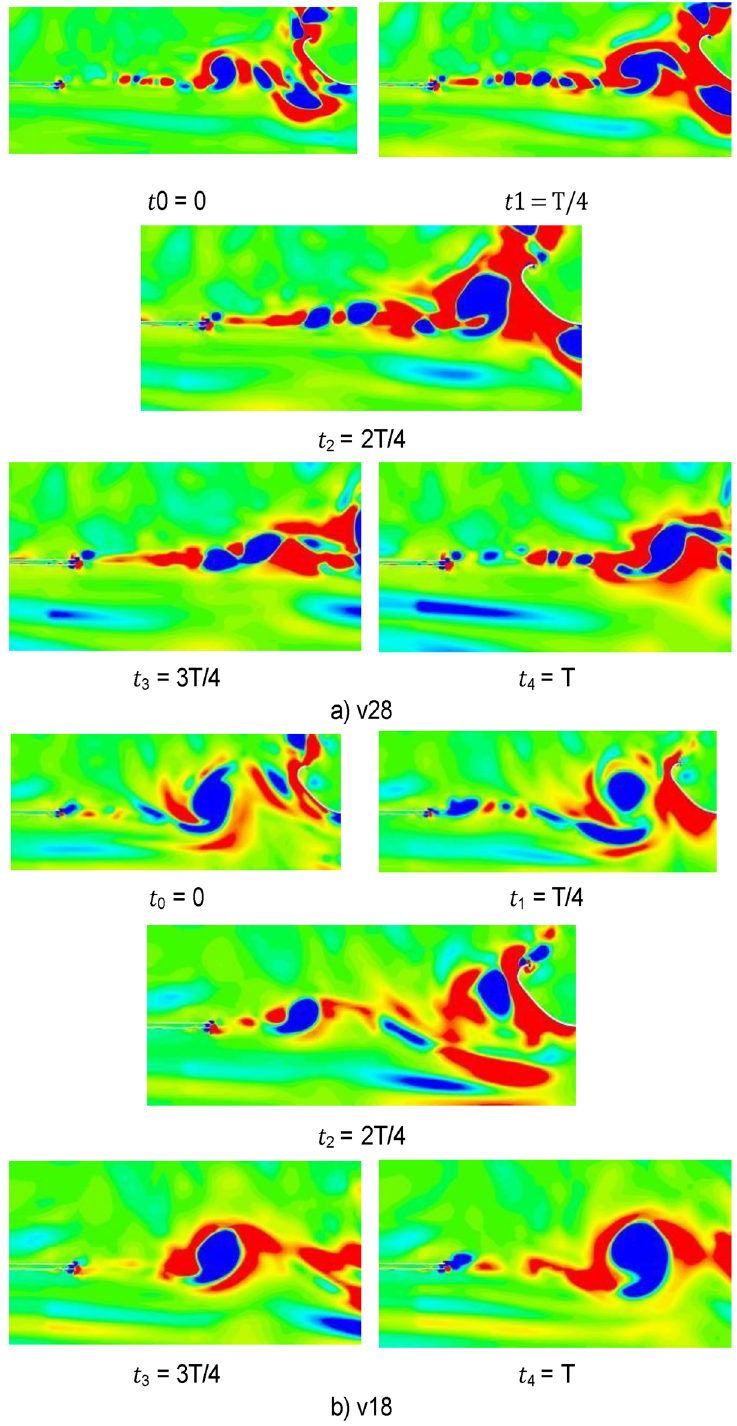
Figure 46. Single cycle lambda 2 cloud diagram of two representative working